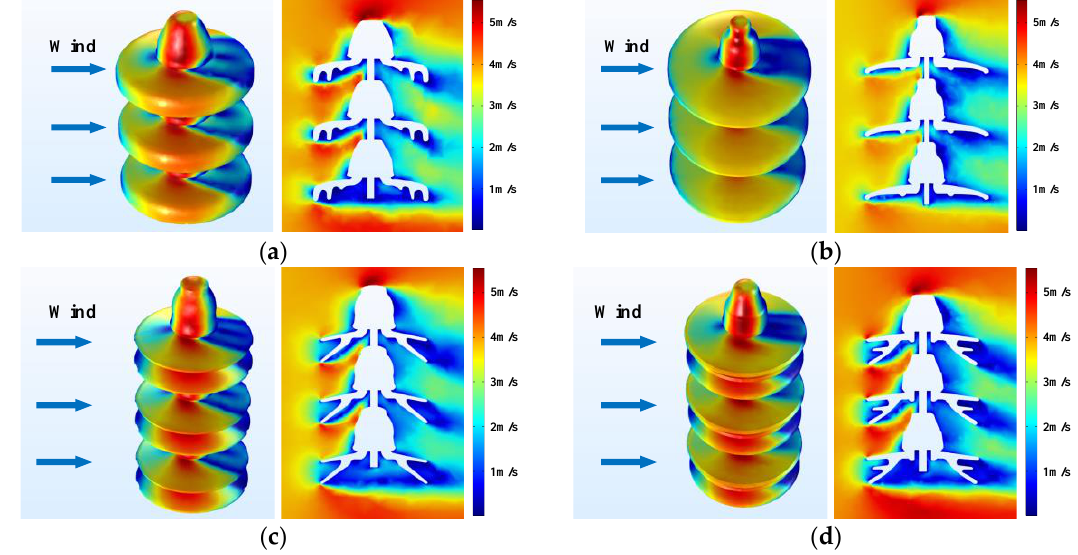
Figure 10. Airflow field diagram of different aerodynamic shapes under 4 m/s wind speed: ( a ) bell type insulator; ( b ) aerodynamic type insulator; ( c ) double umbrella type insulator; and ( d ) three umbrella type insulator.